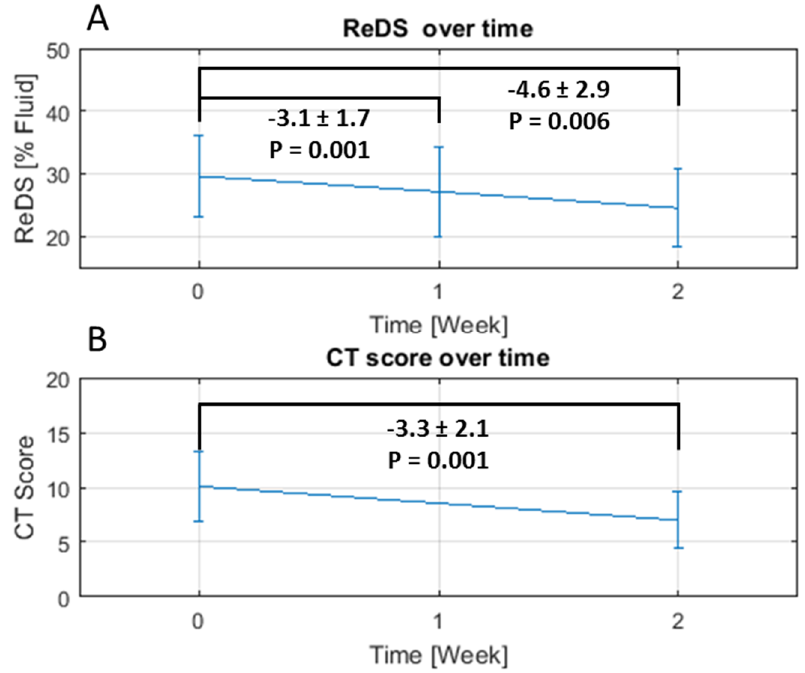
Figure 3. Average change in ReDS measurements ( A ) and CT score ( B ) over time.